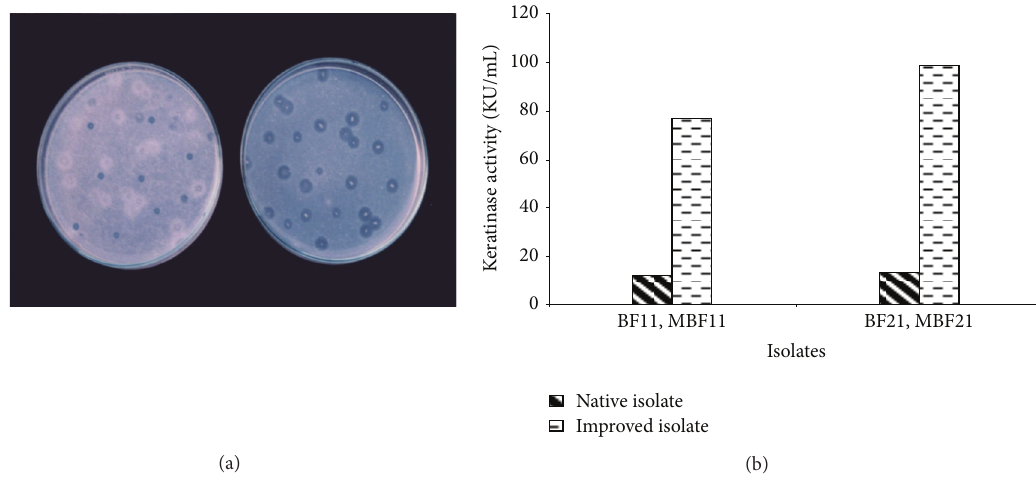
Figure 2: (a) Screening of improved isolates on milk agar plates. (b) Comparison of keratinase activity between native and improved isolates.